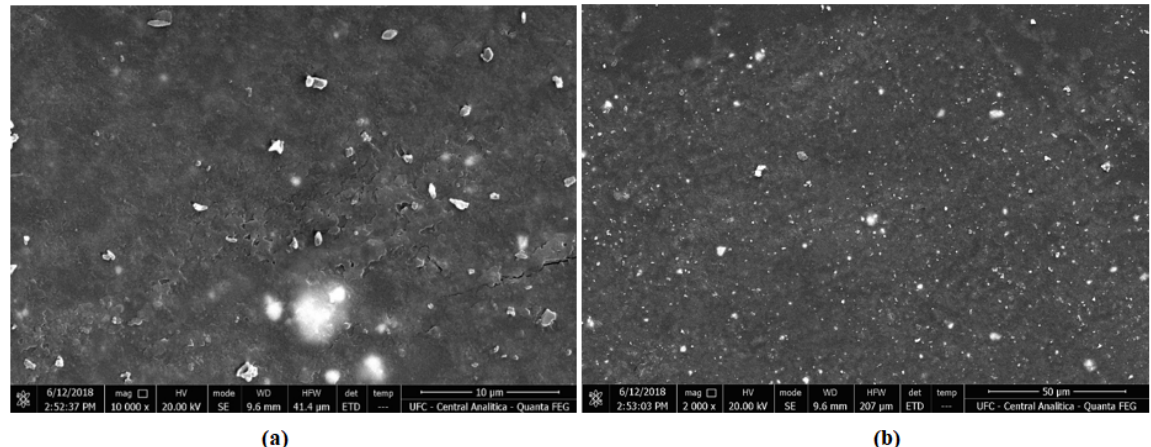
Figure 5: Micrograph of the selective surface sample of 100% titanium oxide, with magnification factor of: (a) 10000x and (b) 2000x.